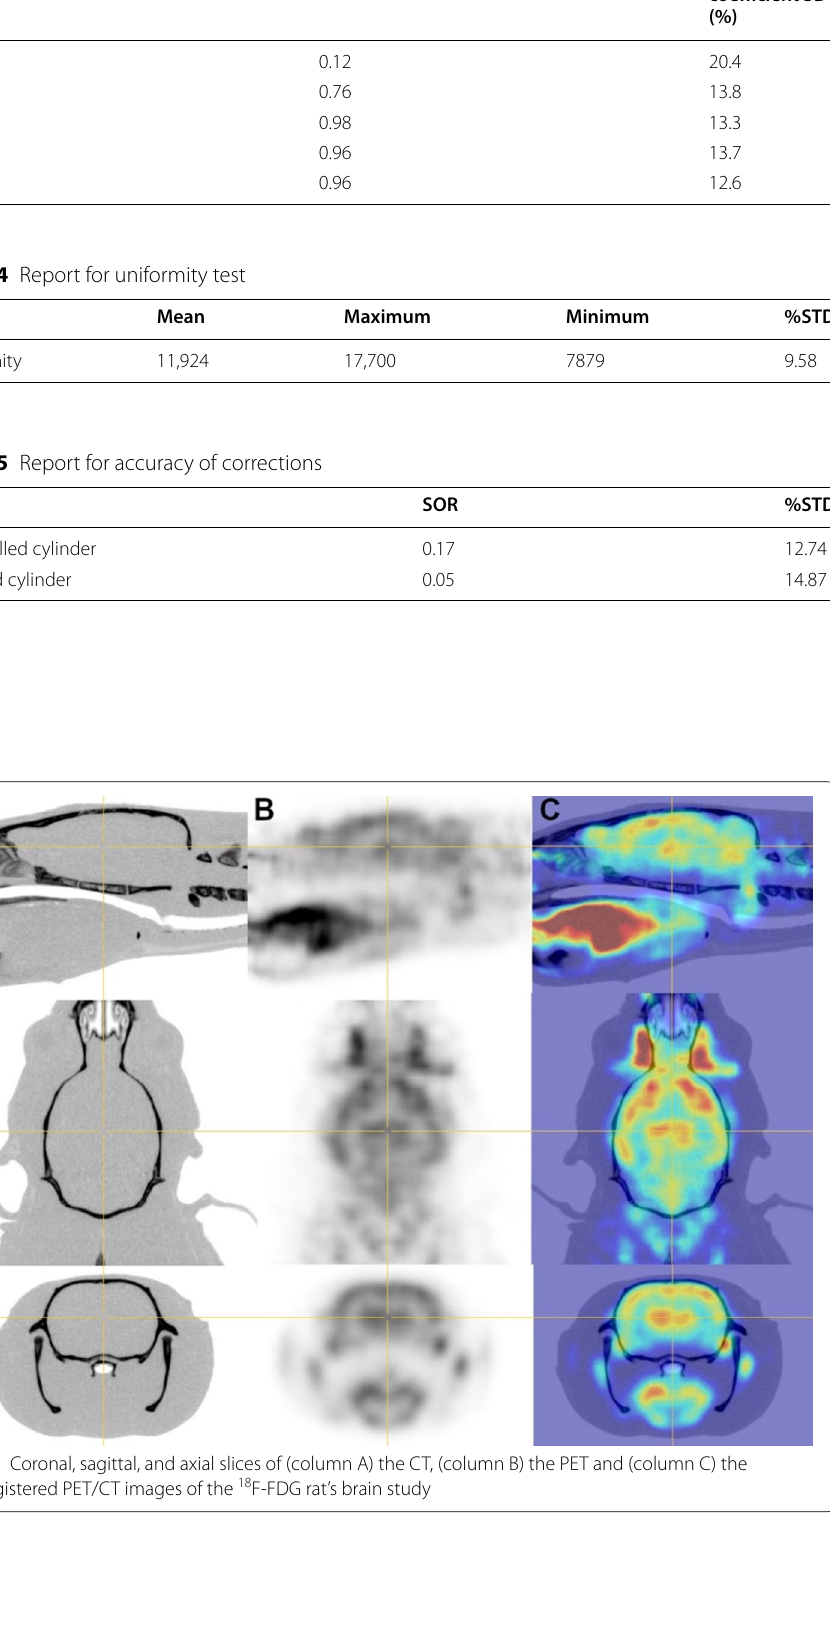
Table 3 Recovery coefficient measurements obtained using the IQP Rod diameter (mm)